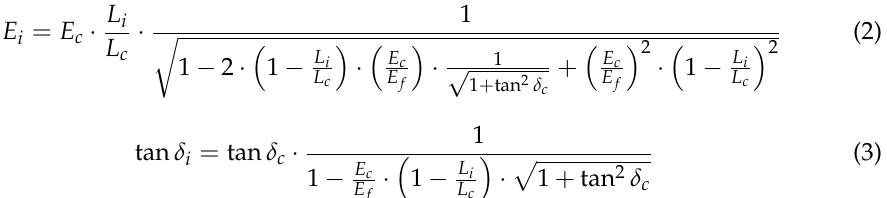
) between adjacent i